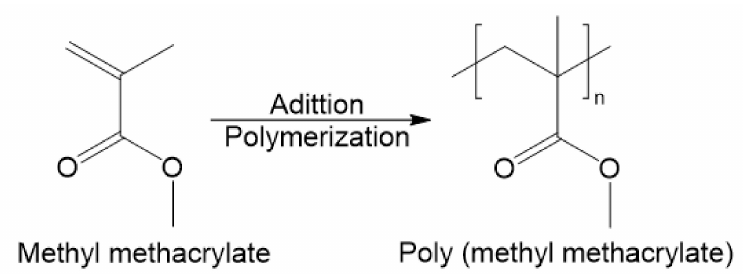
Figure 3. Synthesis of PMMA by addition polymerization of MMA (adapted from